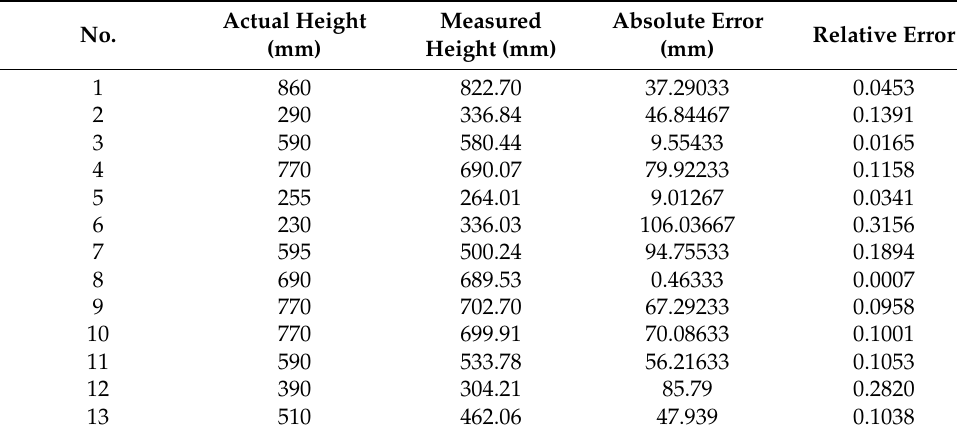
Table 4. Difference between the measured value and estimated value.